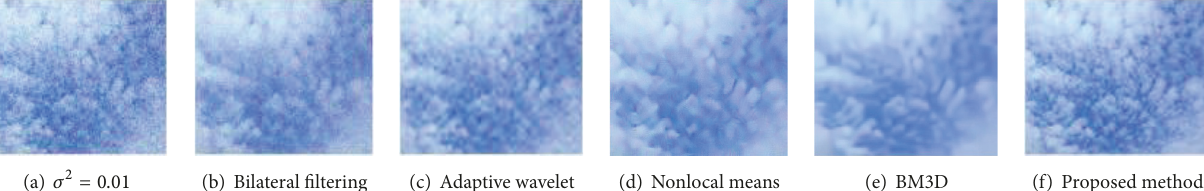
Figure 11: Image 10: comparison of various experimental results under noise variance 𝜎 2 = 0.01 .